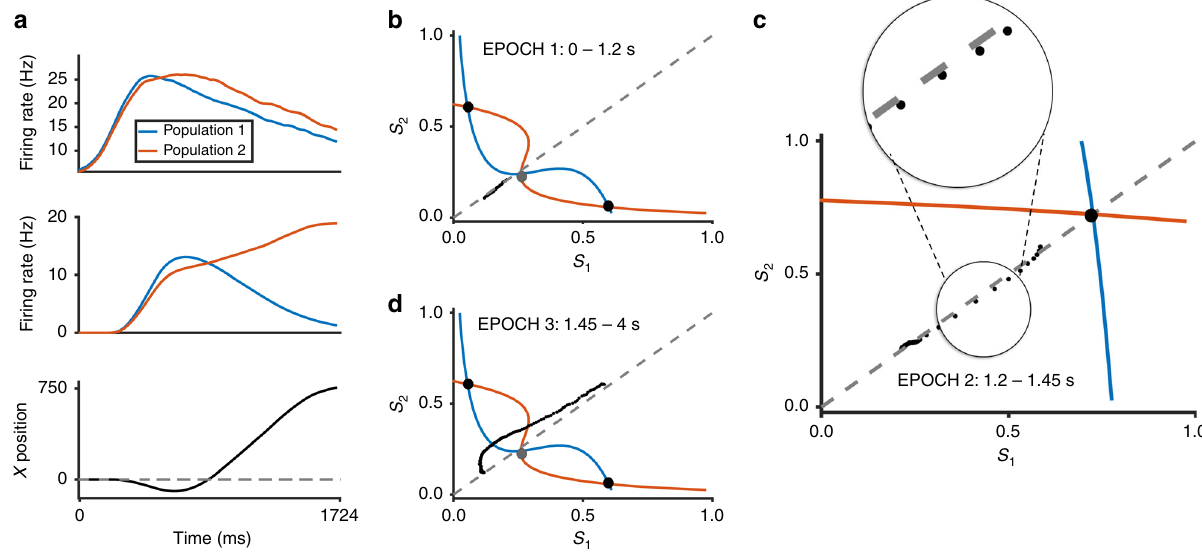
Fig. 5 Neural circuit mechanism of change-of-mind behaviour. a Trial-averaged ( n = 17) timecourse of fi ring rates in sensorimotor module (top), motor module (middle) and corresponding motor trajectory (bottom). Evidence quality ε = 3.2 (favouring population/choice 2/Right). Populations compete after stimulus onset (time 0). As motor starts moving in one direction (without reaching the target), a reversal of neural activity dominance in sensorimotor module occurs, leading to a change-of-mind. Note: fi nal decision is made by the motor output in X space (bottom). b Immediately upon stimulus onset ( ε = 3.2, favouring choice 2/Right), the sensorimotor population activity trajectory (black dotted line) in phase space deviates from phase plane diagonal. Black fi lled circles: stable steady states representing the two choices i.e. choice attractors; grey fi lled circle: saddle-like unstable steady state. Refer to main manuscript regarding content of the phase plane (e.g. nullclines). c During the middle epoch of the trial, large excitatory feedback from uncertainty- monitoring module causes phase plane to recon fi gure, and a new choice-neutral stable steady state appears that aids the initially losing neural population (population 2). Trajectory is now drawn towards this stable steady state, towards the phase plane diagonal. Inset: Zoom in. d During the later epoch of the trial, both sensorimotor populations receive lesser excitatory feedback from the uncertainty-monitoring module, resulting in the phase plane reverting closer to the previous condition during the early epoch of the